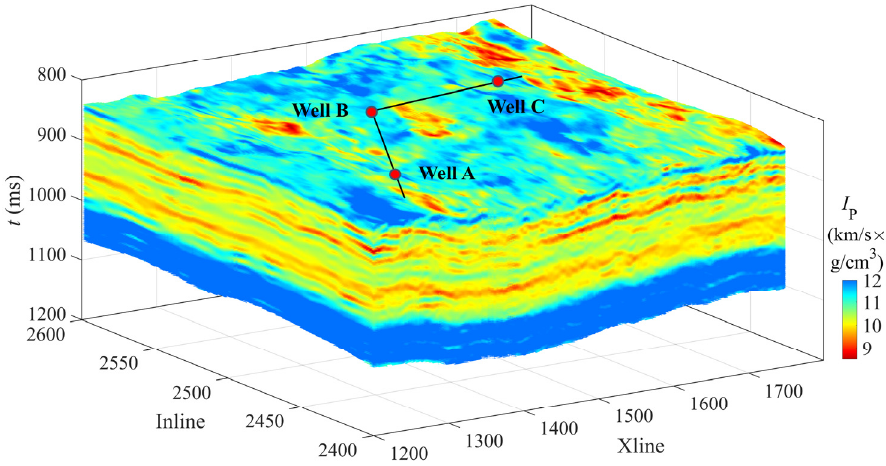
Figure 16. Seismic-inverted 3D cube of V P / V S in the tight sandstone formations in the study area.